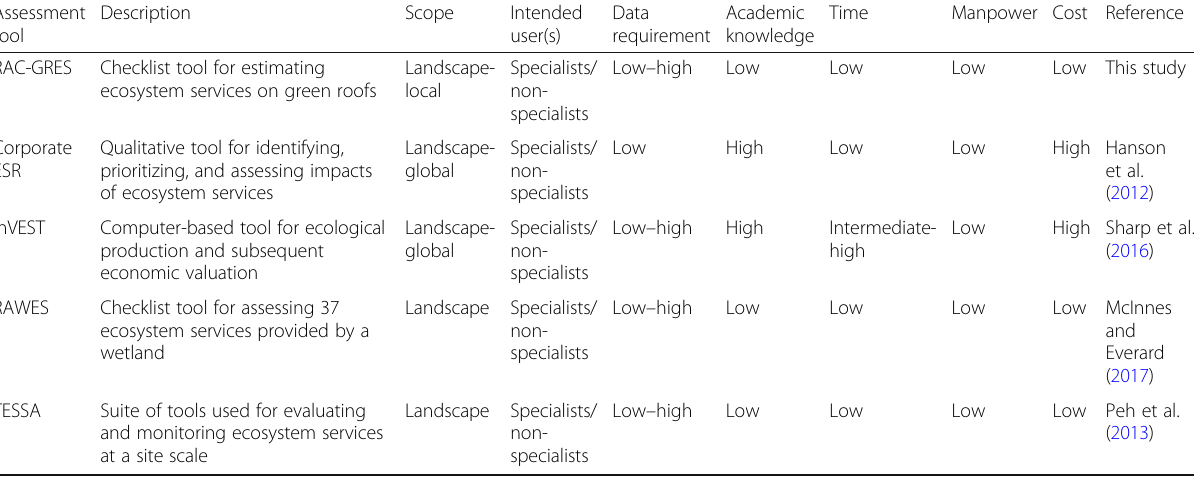
Table 6 Comparison of key attributes of different ecosystem service assessment tools, derived from Peh et al. (2013) and Waage and Stewart